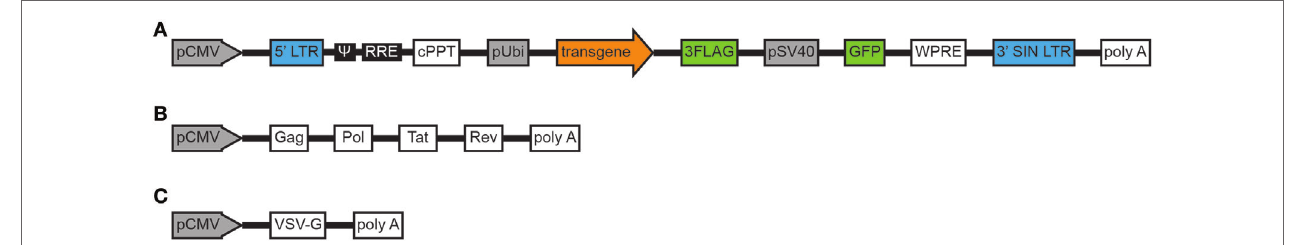
FigUre 1 | Schema of the plasmids constituting the lentiviral vector. Backbone plasmid (a) . Helper plasmid 1.0 (B) . Helper plasmid 2.0 (c) . Abbreviations: pCMV, cytomegalovirus promoter; LTR, long terminal repeat; ψ , packaging signal; RRE, rev responsive element; cPPT, central polypurine tract; pUbi, ubiquitin promoter; 3FLAG, three flag tags; pSV40, simian virus 40 promoter; GFP, green fluorescent protein; WPRE, woodchuck hepatitis virus posttranscriptional regulatory element; 3 ′ SIN LTR, 3 ′ self-inactivating LTR, polyA, bovine growth hormone polyadenylation signal, Gag, structural proteins (Pol), replication enzymes, Tat, trans-activator; Rev, regulatory proteins; VSV-G, vesicular stomatitis virus